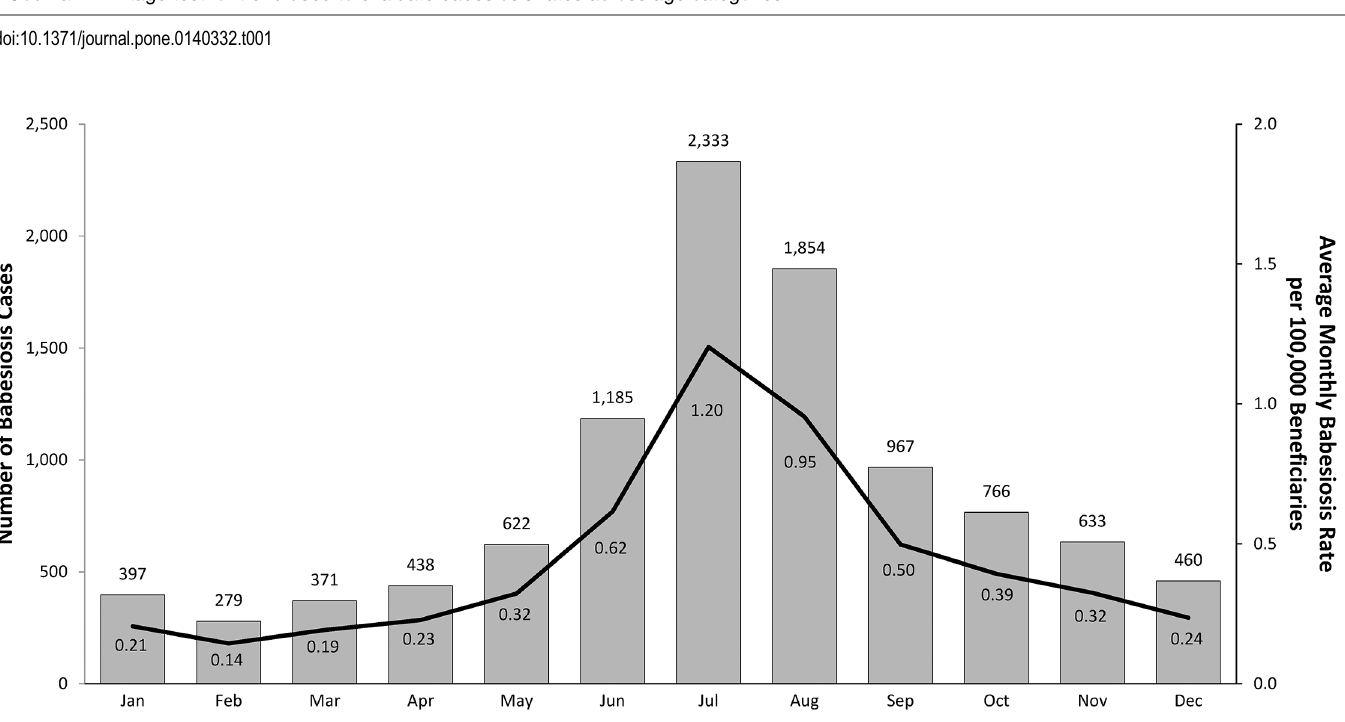
Fig 1. Babesiosis Cases (Gray Bars) and Average Rates (Black Line) by Month of Diagnosis among Elderly Medicare Beneficiaries, 2006 –